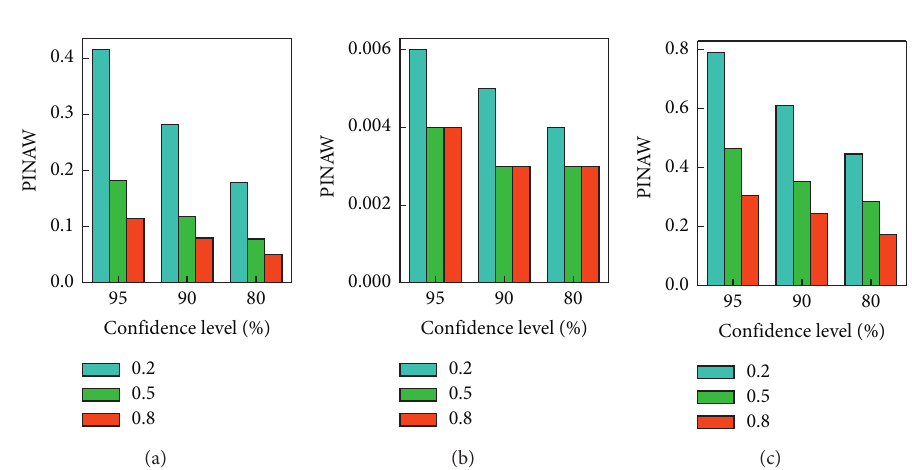
Figure 9: Histogram of PINAW for all prediction